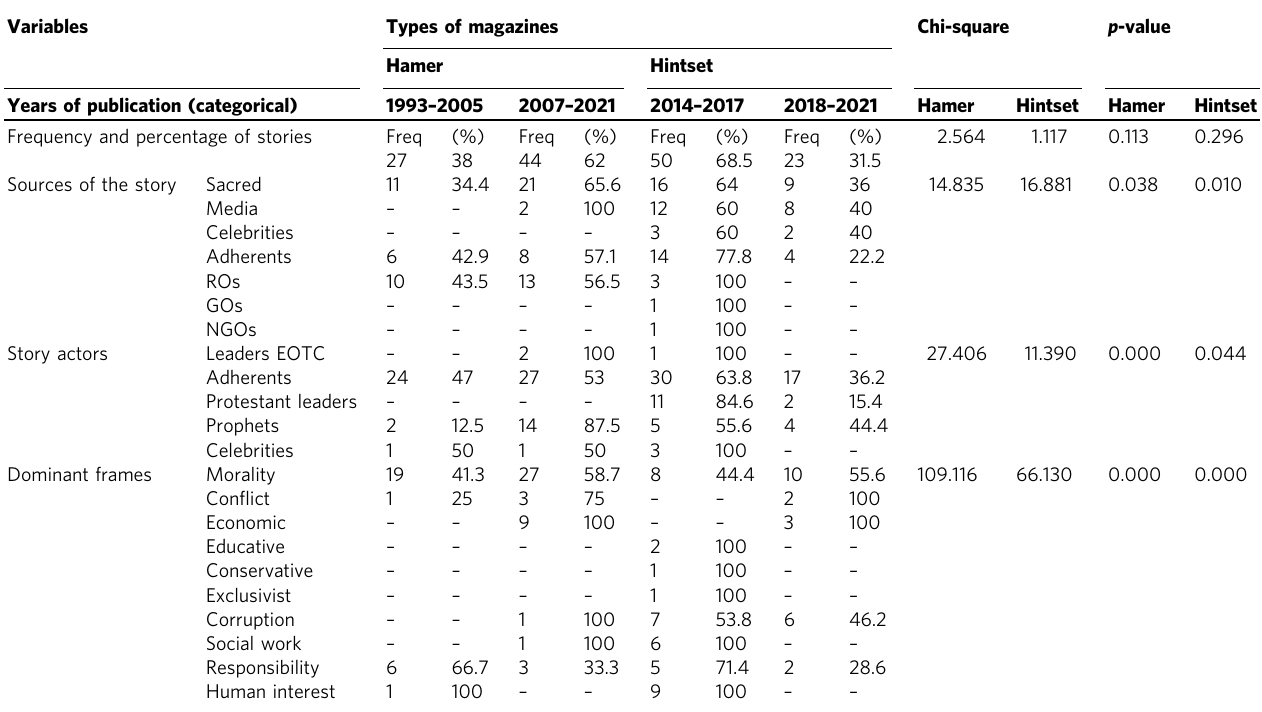
Table 6 Cross-tabulation: Moral development * Types of publication * Years of publication * Sources * Story actors * Dominant